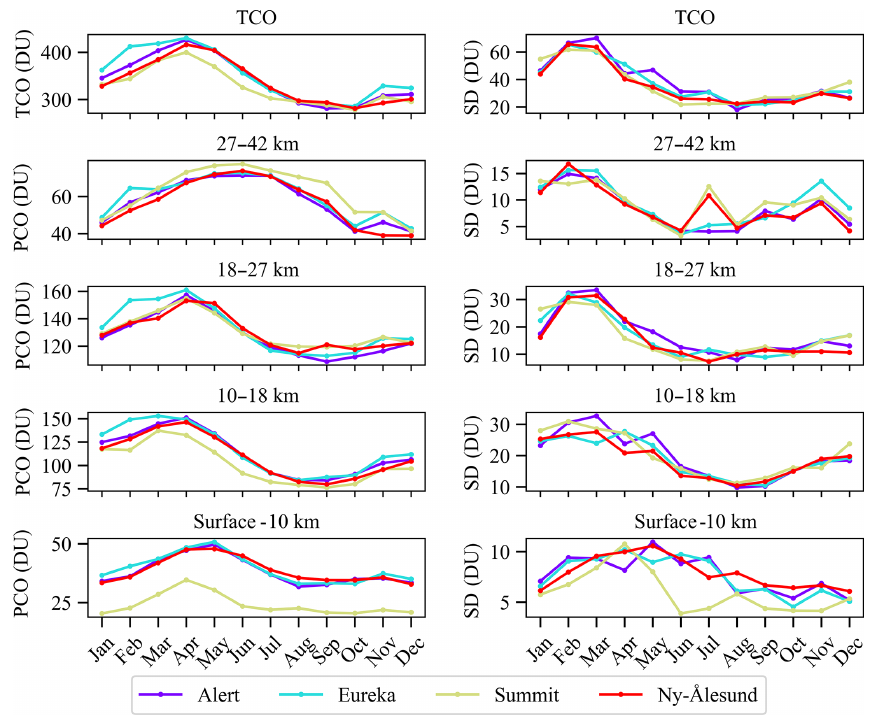
Figure 5. Monthly mean (left panels) and standard deviations (right panels) of total column ozone (TCO) and partial column ozone (PCO) for 2005–2017 for different atmospheric layers from merged ozonesonde and MLS for Alert, Eureka, Summit, and Ny-Ålesund. The layers represent the troposphere (surface–10km), the lower stratosphere (10–18km), the middle stratosphere (18–27km), and the upper stratosphere (27–42km). The TCO is calculated from the surface to